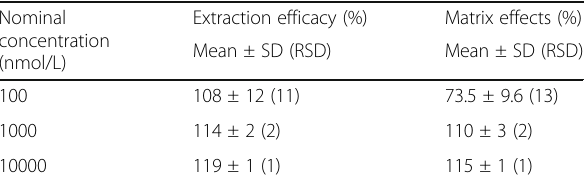
Table 2 Extraction efficiency ( n = 3) and matrix effects ( n = 3) for the analysis of bromophenol-thiosemicarbazone hybrid in rat plasma